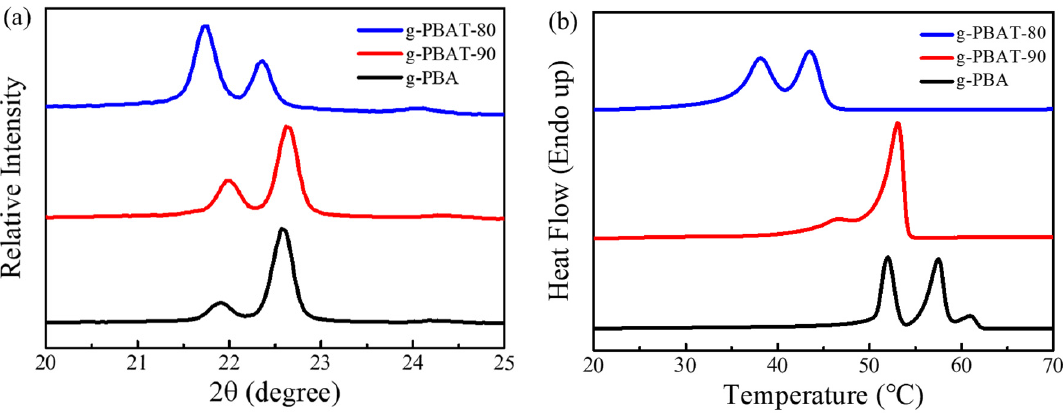
Figure 1. ( a ) WAXD patterns; and ( b ) DSC heating curves of g-PBA, g-PBAT-90, and g-PBAT-80 polyesters.